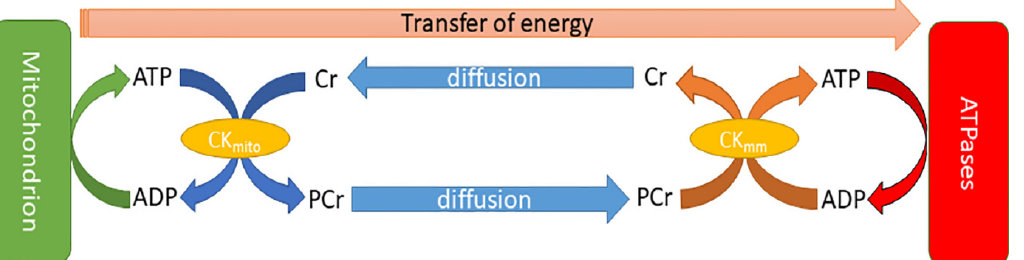
Figure 2. Schematic of energy transfer through the cell. Reproduced with permission from